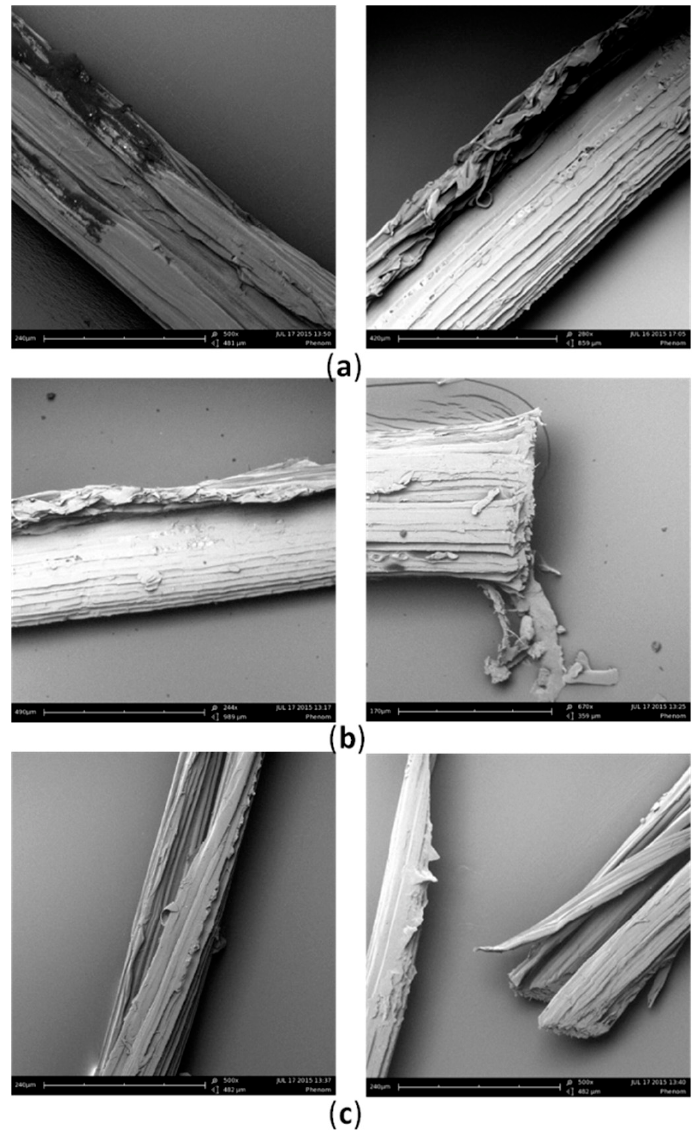
Figure 2. SEM pictures of banana fibers: ( a ) untreated fibers; ( b ) fibers after Treatment 1; ( c ) fibers after Treatment 2.